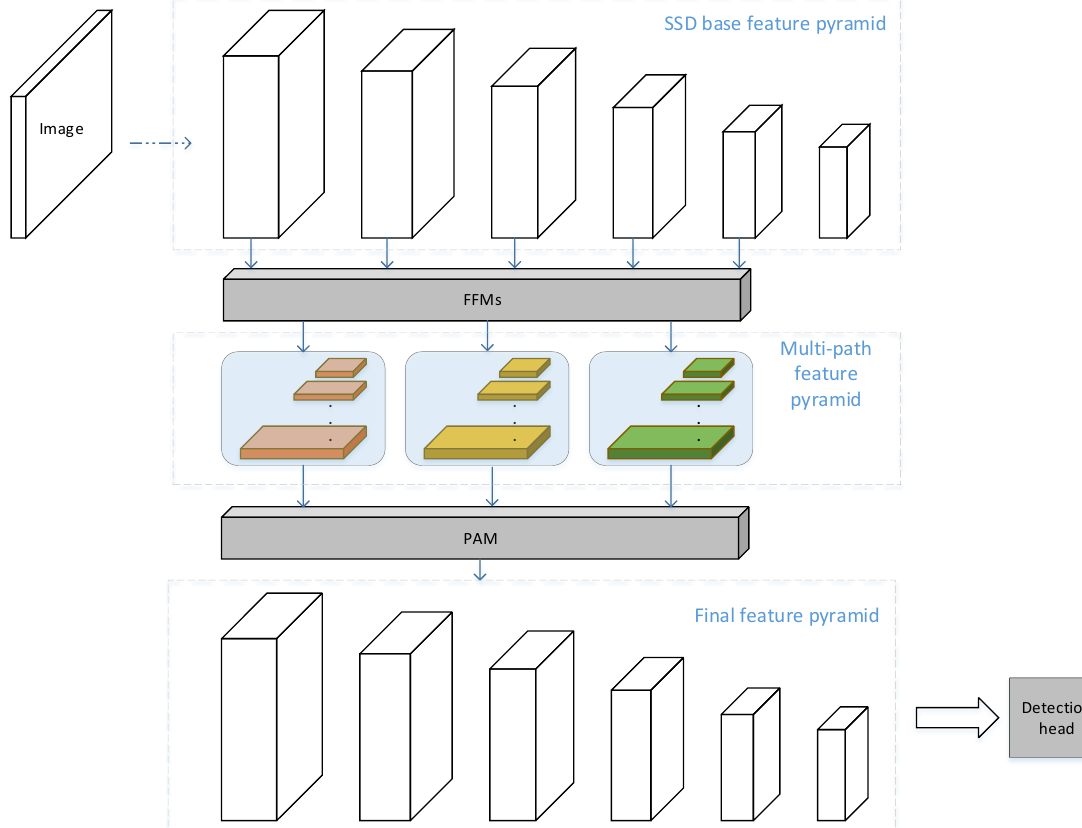
Figure 1. Our model pipeline. From top to bottom, each part indicates: Single Shot Detector (SSD) base feature pyra- mid, multipath feature pyramids generated through Feature Fusion Modules, final feature pyramid out from pyramid aggregation